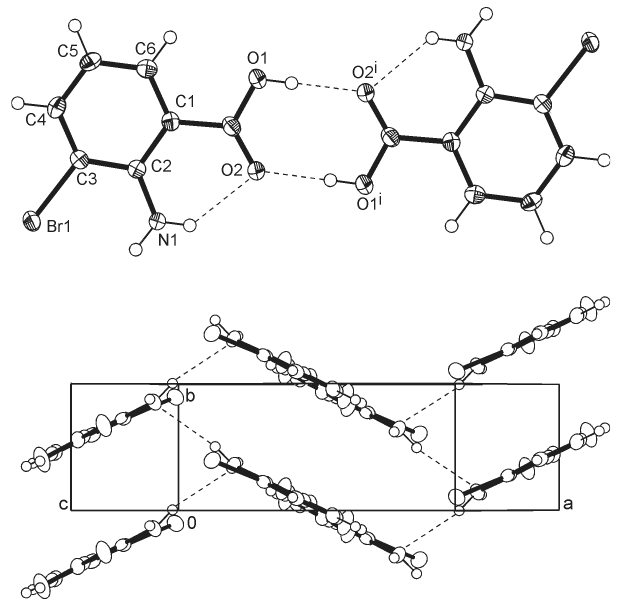
Table 1. Data collection and handling.